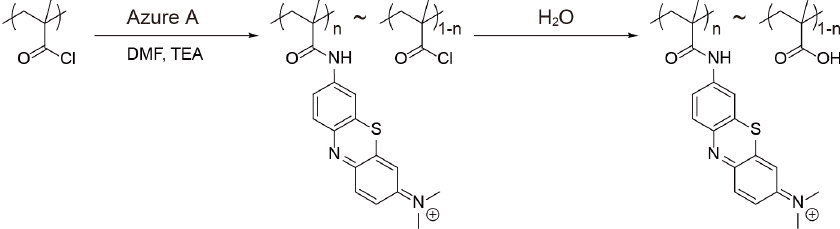
Figure 2. Synthesis of AA-PMA.